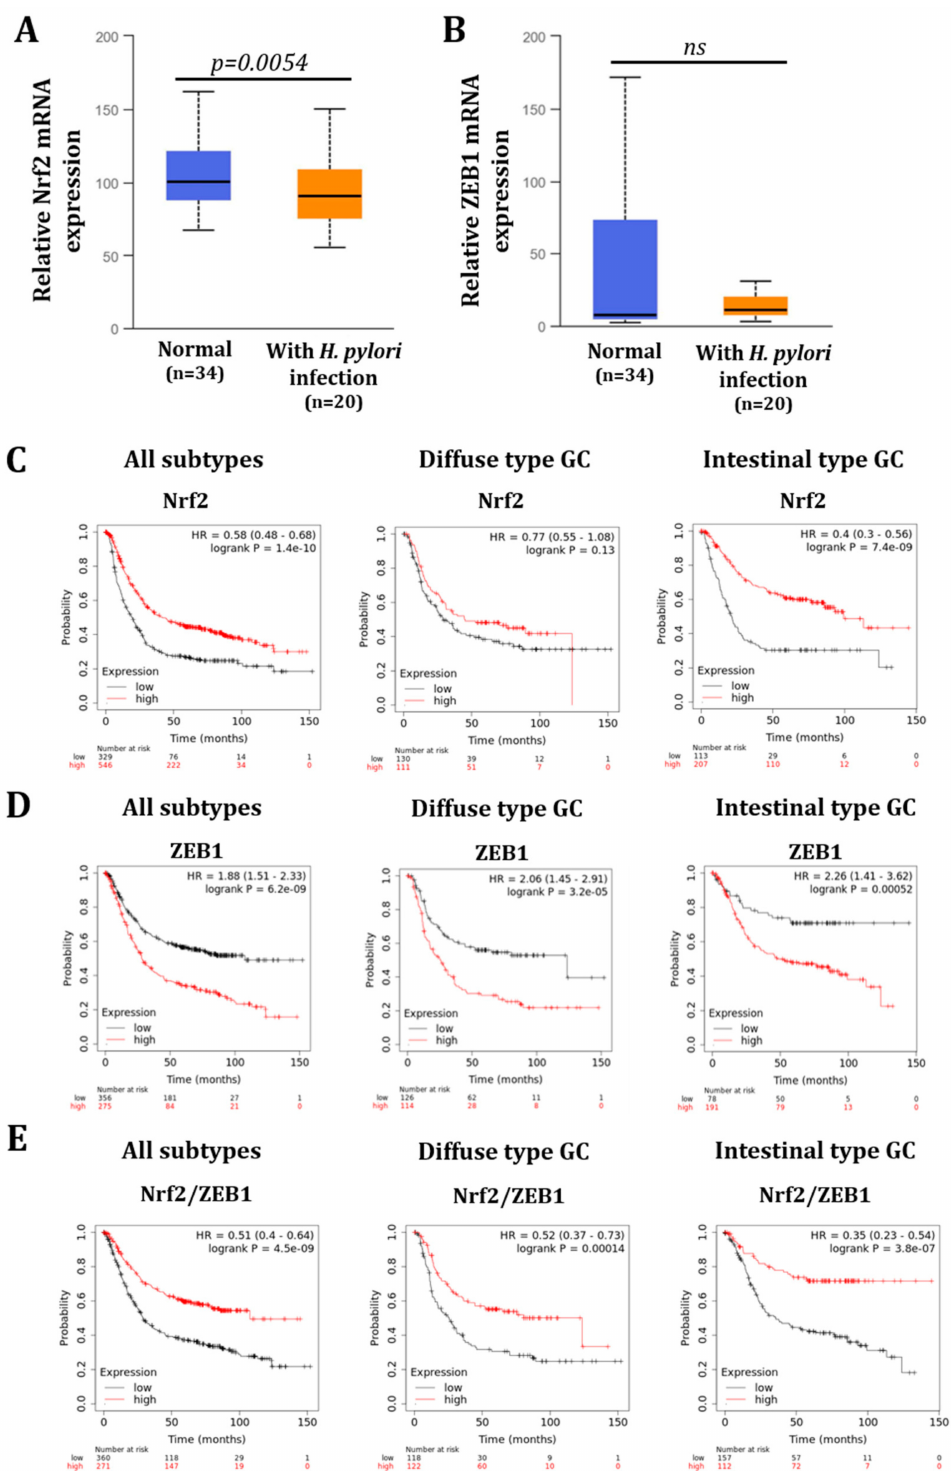
Figure 7. In silico analyses reveal that Nrf2 expression is down-regulated in patients’ H. pylori -infected gastric tissues and is associated to a poorer overall survival probability. ( A , B ) Evaluation of NRF2 ( A ) and ZEB1 ( B ) gene expression in normal or H. pylori -infected gastric tissues assessed using the UALCAN cancer database. ( C , D ) KMplot database analyses showing the overall survival probability of GC patients according to NRF2 ( C ) and ZEB1 ( D ) expression for all subtypes or diffuse type GC or intestinal type GC. ( E ) KMplot database analyses showing the overall survival probability of GC patients according to NRF2/ZEB1 expression ratio for all subtypes or diffuse type GC or intestinal type